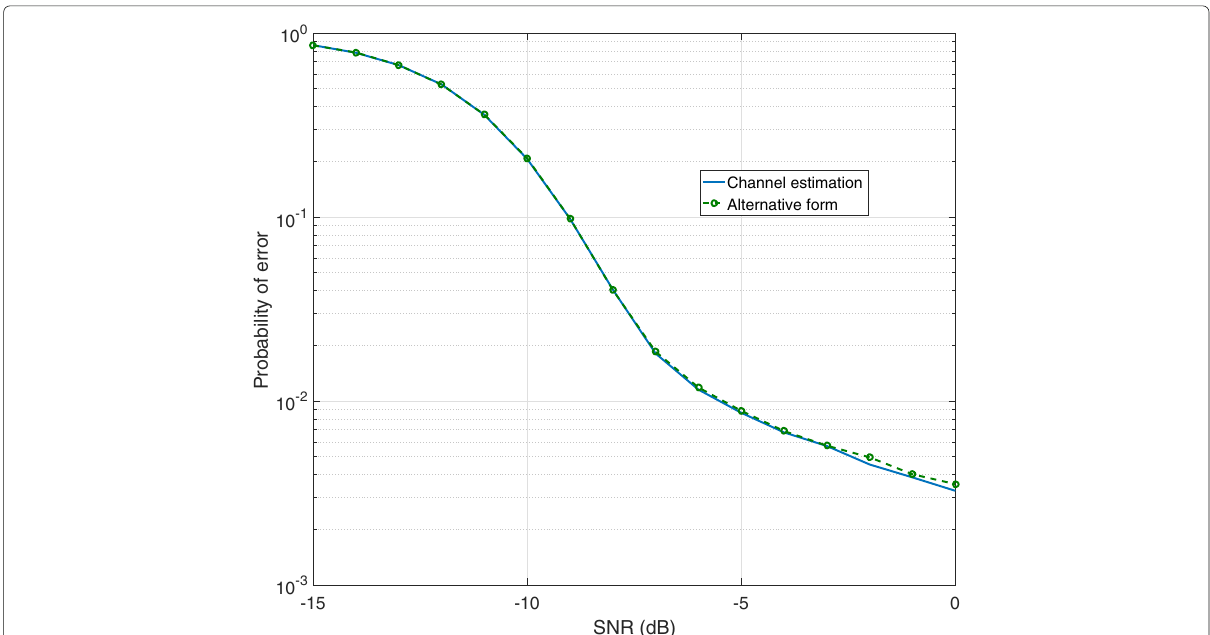
Fig. 9 Error probability versus SNR (dB) of the suggested DFT-based implementation (15) compared with the alternative form in a frequency selective